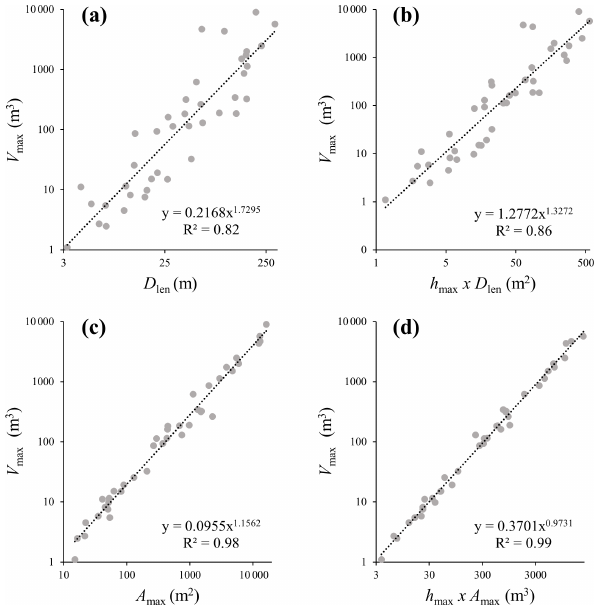
Figure 3. Power regression relationships between the maximum volume of the beaver ponds ( V max ) and (a) the length of the beaver dams ( D len ), (b) the product of the maximum depth of the ponds ( h max ) and the length of the beaver dams, (c) the maximum surface area ( A max ) of the ponds, and (d) the product of the maxi- mum surface area and maximum depth of the pond.